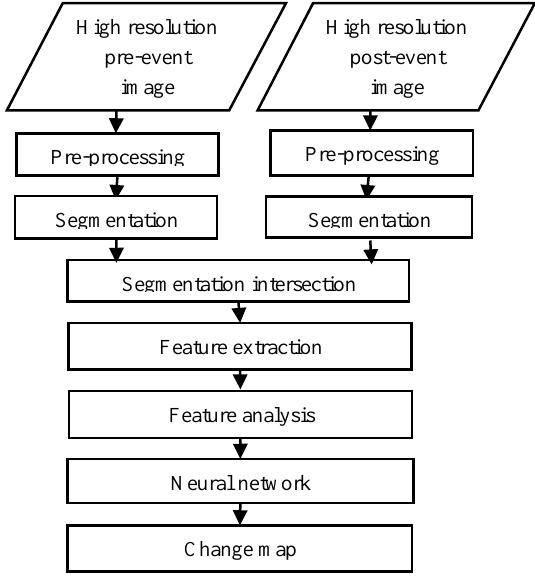
Figure1. Flowchart of the proposed method for